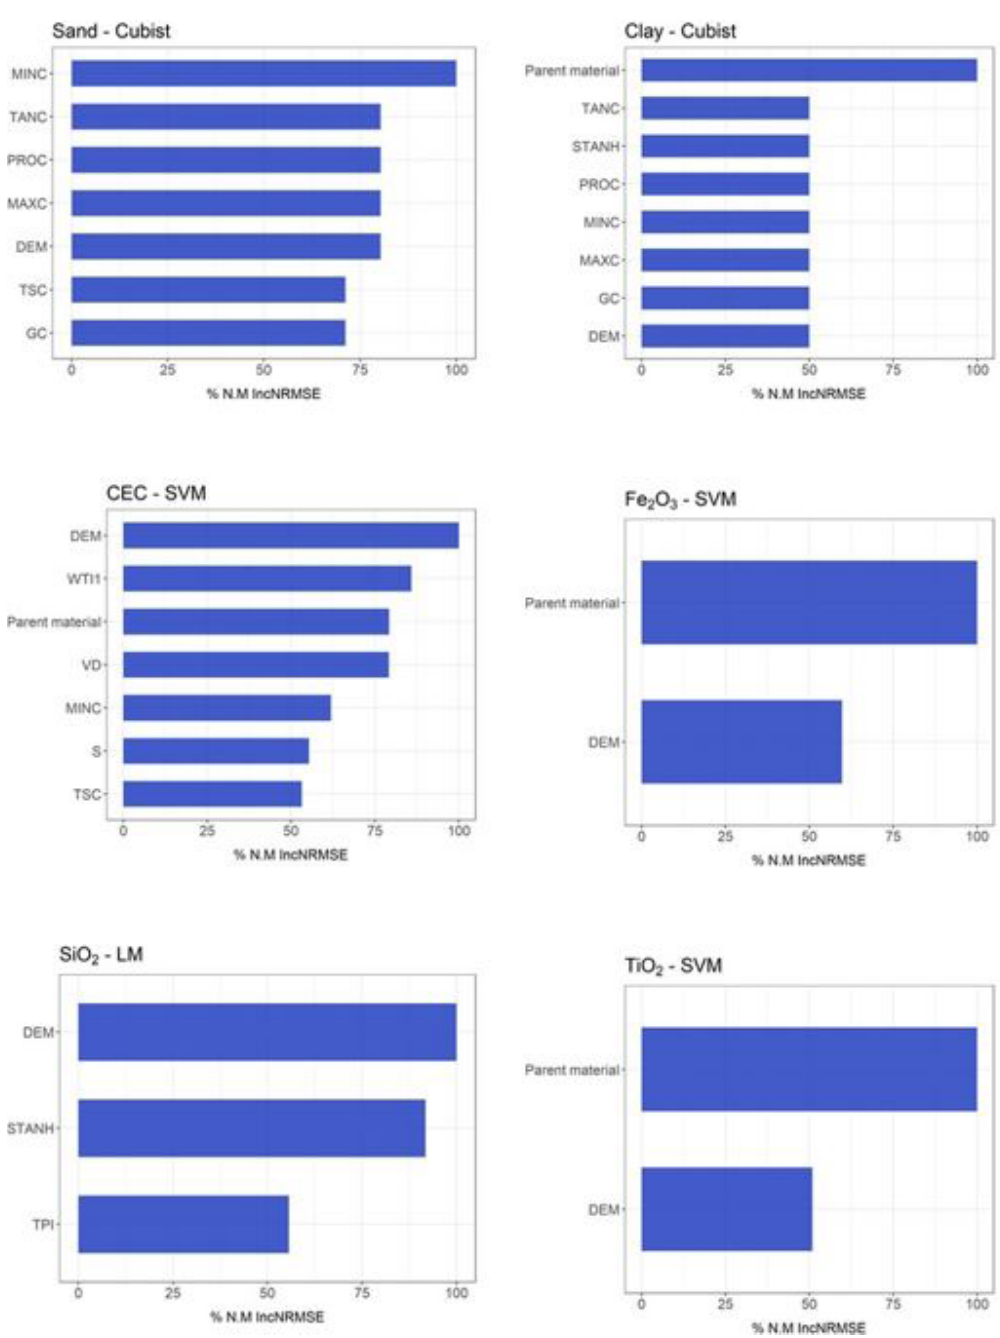
Figure 4. Variable importance for non-use of geophysical sensors (only variables that contributed more than 50% are presented here). For further details, see